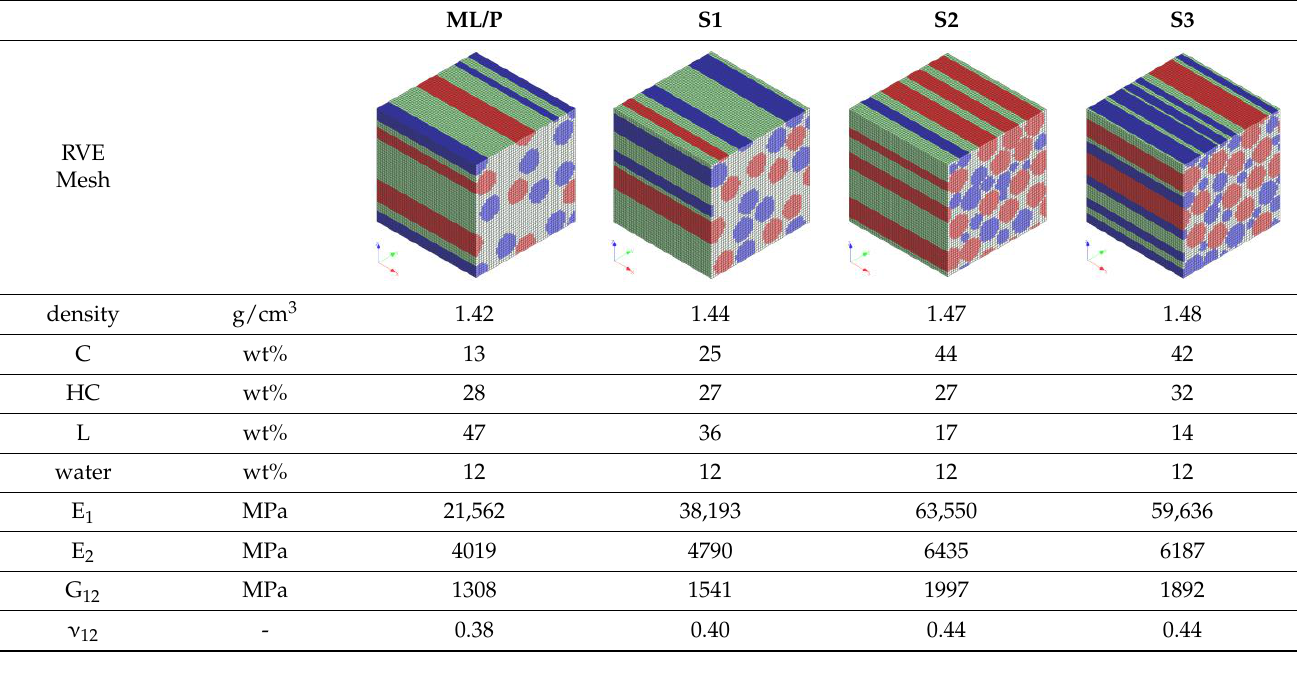
Table 3. Mechanical properties of the unidirectional cell wall single layers determined by RVE modeling for 12% moisture and 23 °C temperature (hemicellulose — blue, cellulose — red, lignin — green).